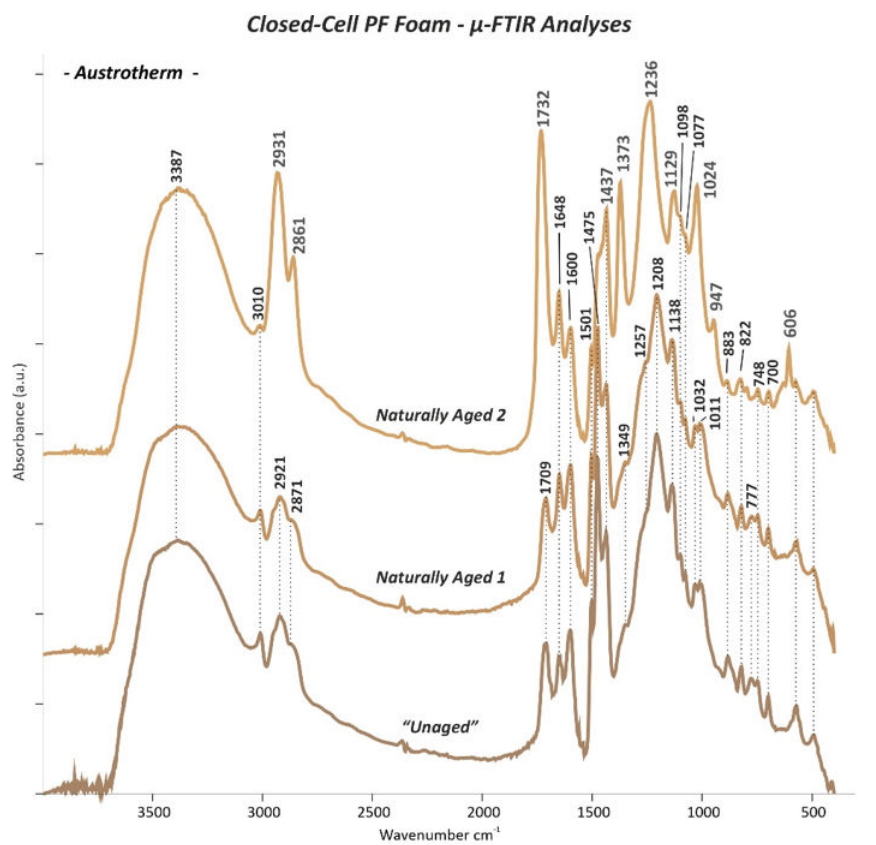
Figure 13. µ -FTIR spectra of the “Unaged” and Naturally Aged 1 and 2 Austrotherm closed-cell PF foam. Wavenumbers highlighted in grey in the Naturally Aged 2 Austrotherm indicate the typical bands of a PVAc